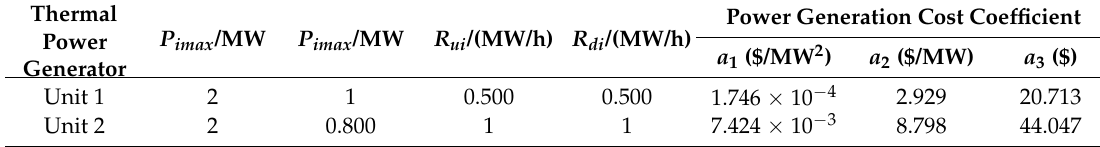
Table 2. Conventional thermal power generator parameters.